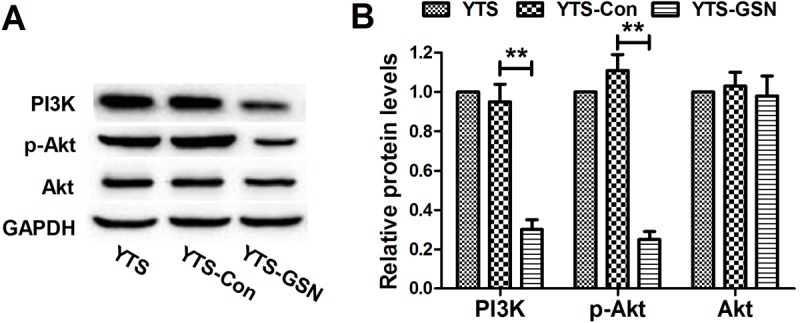
GSN overexpression inhibits the PI3K/Akt pathway in YTS cells. (A,B) Western blot analysis revealed that AKT expression in the three experimental groups was not significantly different. The levels of PI3K and p-AKT in YTS-GSN cells were significantly reduced at 48 h, compared with those in YTS-Con cells. **P<0.01.